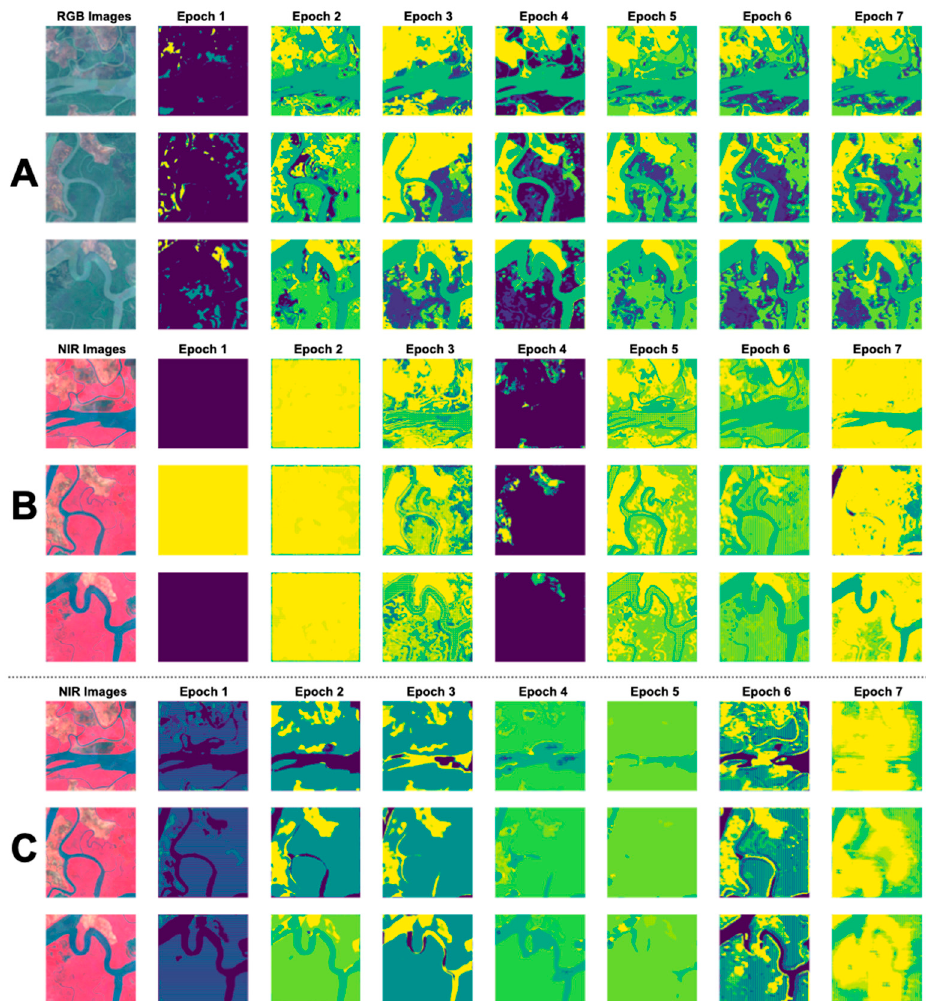
Figure 4. The evolution of the classifications of three scenes in the test set at each epoch for ( A ) the U-Net model (bands B1 to B12) (shown as an RGB image for demonstration purposes), ( B ) the VGG19, and ( C ) the ResNet50 (bands B3, B4, and B8).